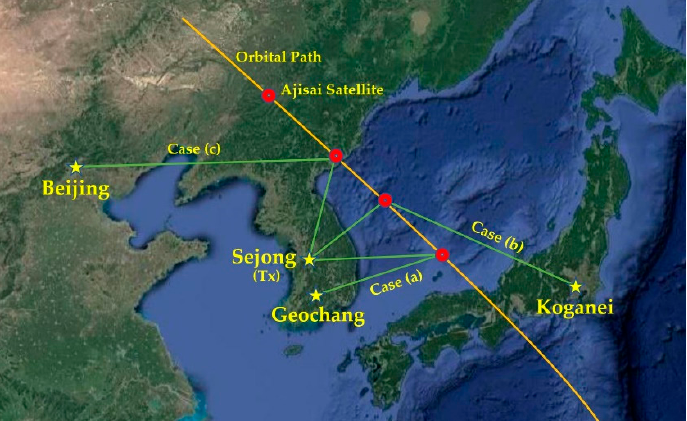
Figure 2. Target ground network for TLTT implementation with three combination cases between laser transmitting station (Sejong) and receiving stations on the google maps.